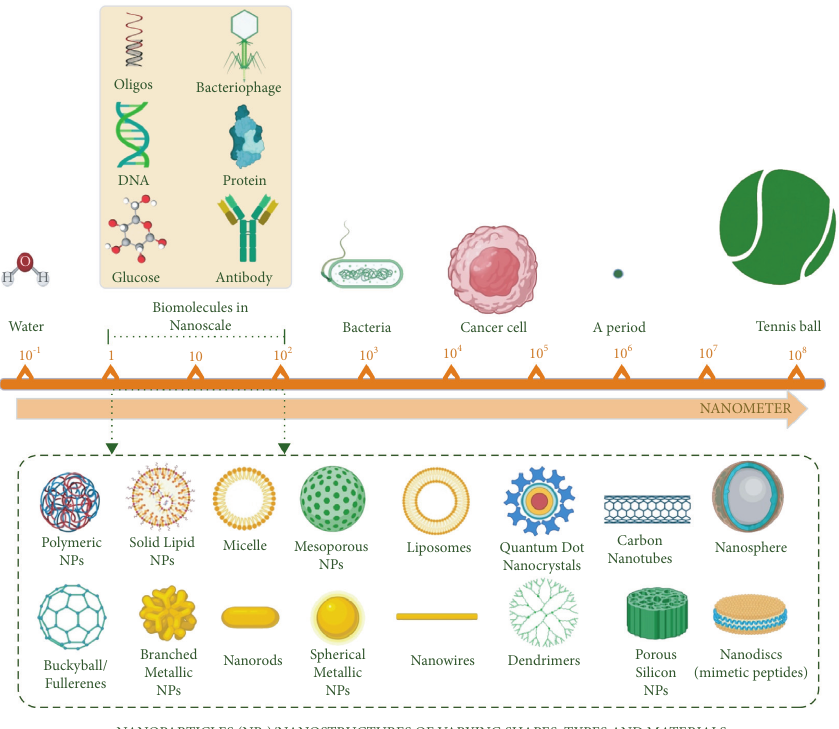
Figure 1: Schematic diagram exhibiting size comparison of nanoparticles (NPs) typically in the range of 1–100 nm, as compared to the other structures. Created with BioRender.com with publication